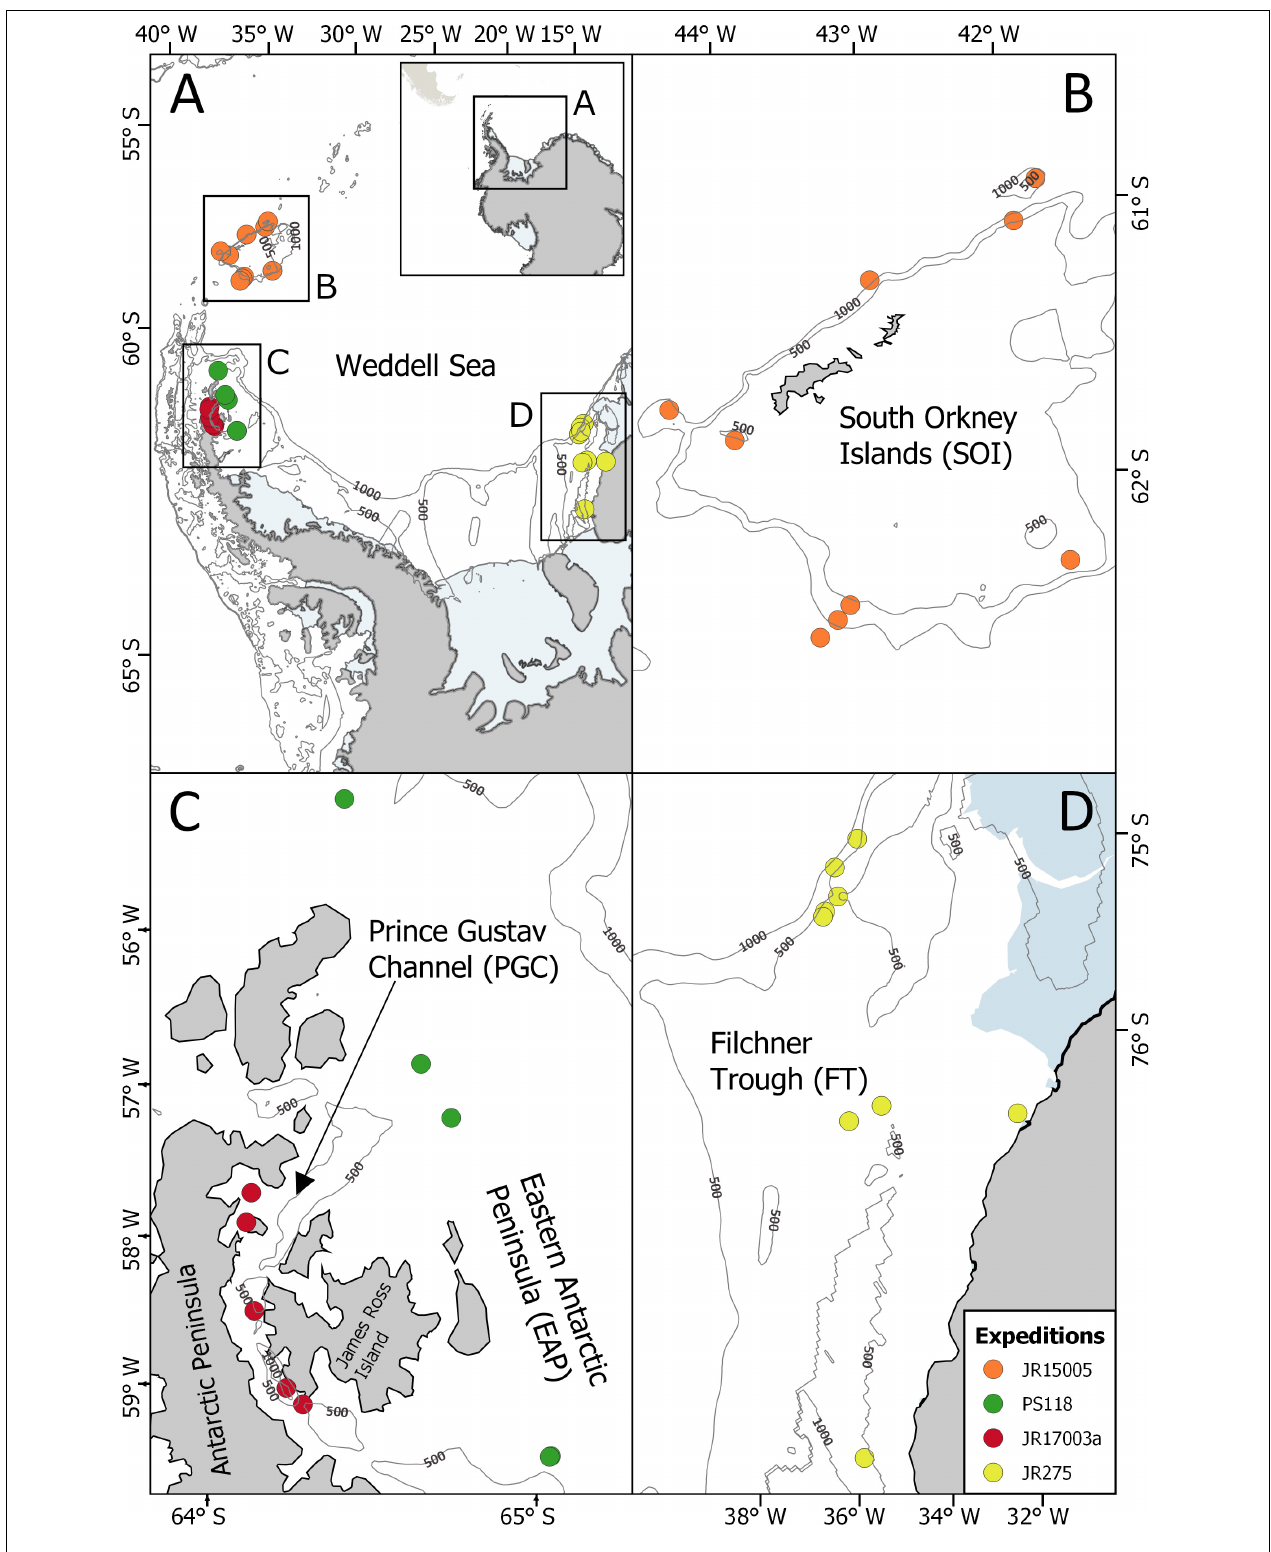
FIGURE 1 | Locations of the EBS stations sampled during the expeditions in the SO (A) ; JR15005, South Orkney Island, SOI (B) ; PS118, Eastern Antarctic Peninsula, EAP (C) ; JR17003a, Prince Gustav Channel, PGC, (C) ; JR275, Filchner Trough, FT, (D) .